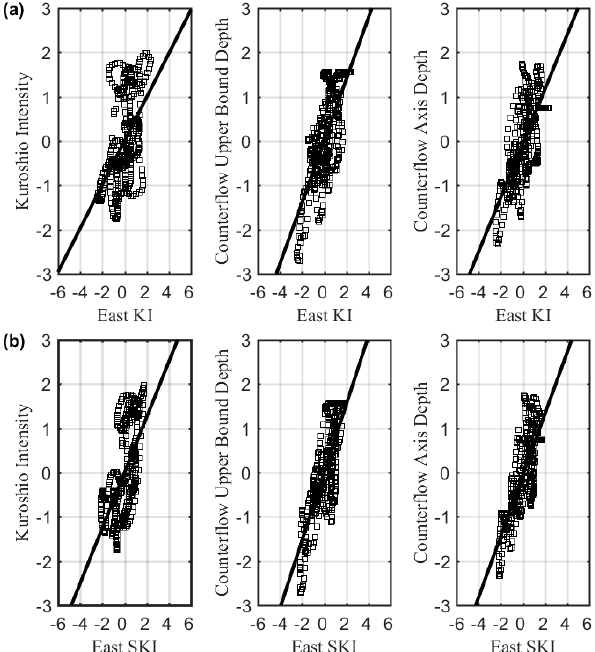
Figure 10. Scatter plots of standardized Kuroshio intensity (INT), counter-flow upper boundary depth and counter-flow axis depth with the KI across the Eastern continental slope (D2–D3, Figure 1). The INT were derived from satellite data along section K (Figure 1). The depths of the upper boundary and axis of the counter-flow were derived from in situ observations. ( a ) The East KI was derived from analysis data; ( b ) the East SKI was derived from satellite altimeter data. A 15-d low-pass filter was applied to the primary data. Locations of each section, segment points and in situ measurement sites are shown in Figure 1.